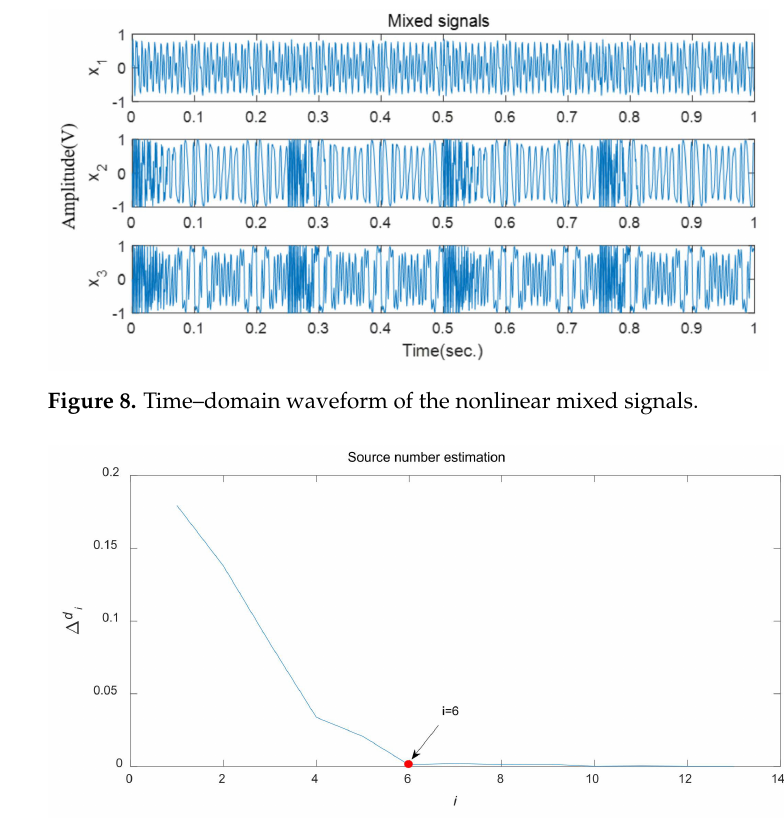
Figure 9. Source number estimation result in nonlinear mixed case.